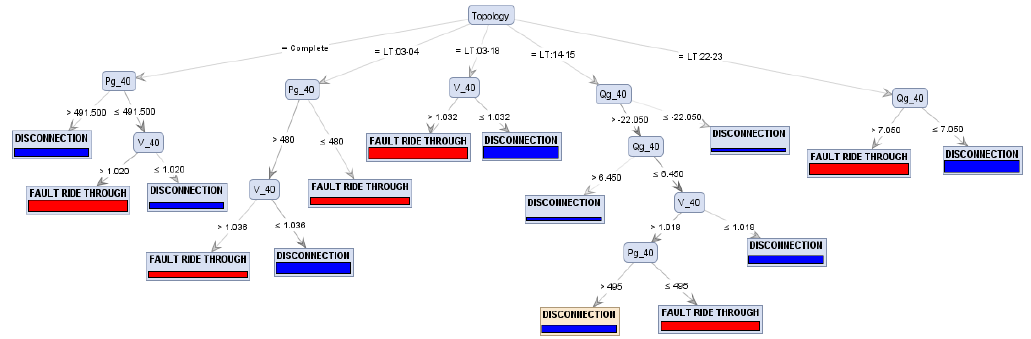
Figure 14. Decision tree for the application of preventive control during local actions.